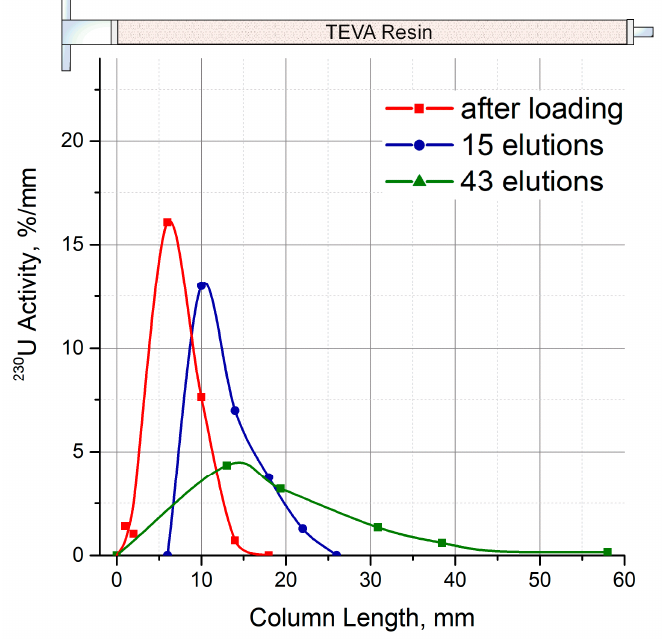
Figure A2. Distribution of 230 U activity along the length of the first column with TEVA resin depending on the number of elutions.